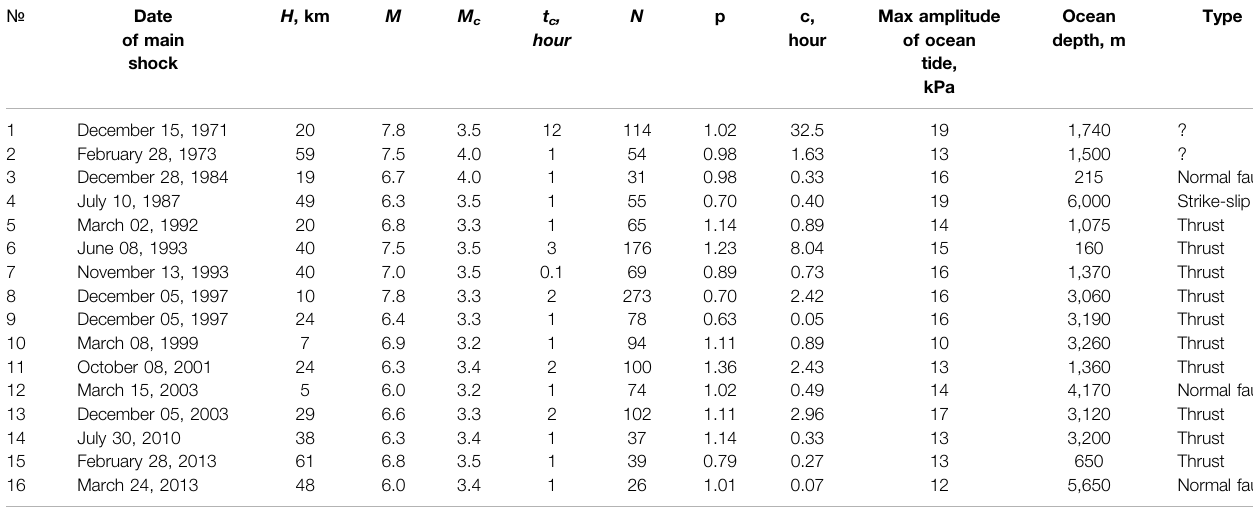
TABLE2| ThemainparametersoftheaftershocksequencesforKamchatkaregion. H denotesthemainshockdepthoffocus; M isthemainshockmagnitude; N denotesthe number of M ≥ M c aftershocks in the interval ( t c , 720 h) measured from the main shock time; the maximum amplitude of ocean tide in the interval ( t c , 720 h) measured from main shock time was converted to pressure, kPa; ocean depth at the epicentre of main event, m; type indicates the focal mechanism of the main